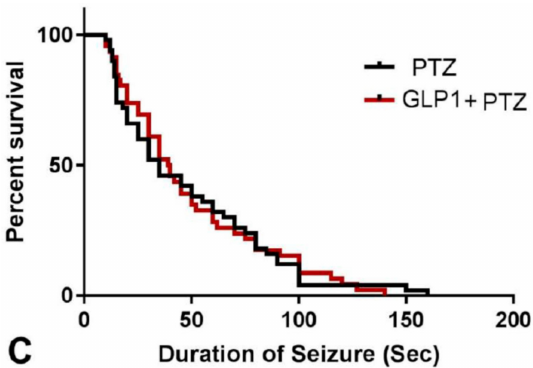
Figure 1. The behavioral e ff ects of GLP1 on PTZ-induced seizures. ( A ) = Seizure score, and Survival analysis vs time to first seizure ( B ) and seizure duration ( C ). Two-way ANOVA test. *, Significant vs. PTZ + Sal.